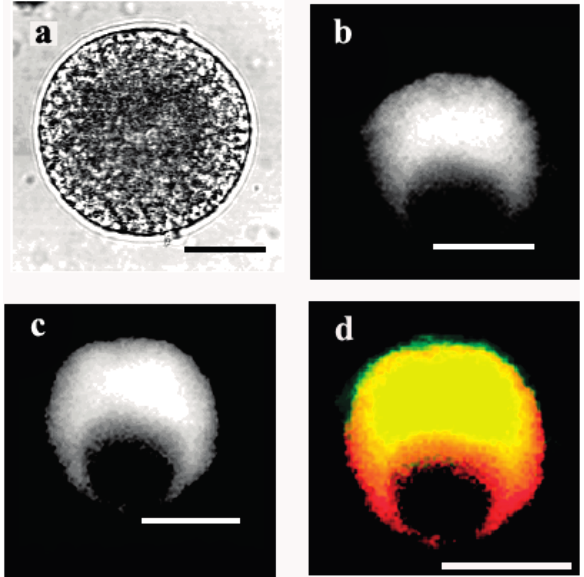
Figure 8. Localization of thapsigargin-sensitive Ca 2+ -ATPase pumps in the wheat egg with fluorescent thapsigargin. ( a ) Transmission-light image of an egg cell; ( b ) stained with fluorescent BODIPY FL ® thapsigargin, which was microinjected previously with 1,1'-dihexadecyl-3,3,3',3'-tetramethylindocarbocyanine perchlorate (DiI) to stain the ER membranes visualized in ( c ). ( d ) The overlay image of ( b ) and ( c ). Scale bars: 20, 25, 25 and 25 µm, respectively.